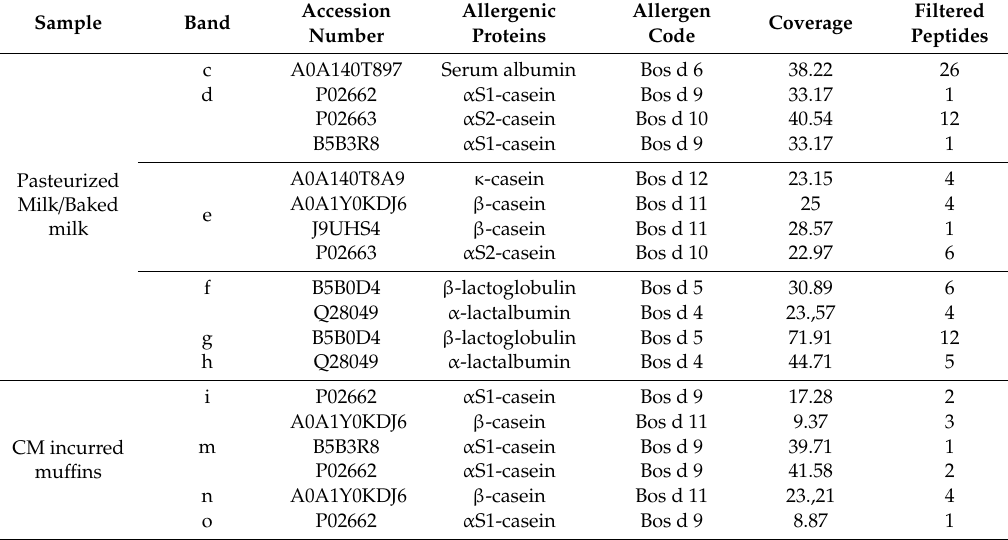
Table 2. Identification of protein bands excised from the SDS gel and analyzed by LC-HR-MS / MS through detection of the proteotypic